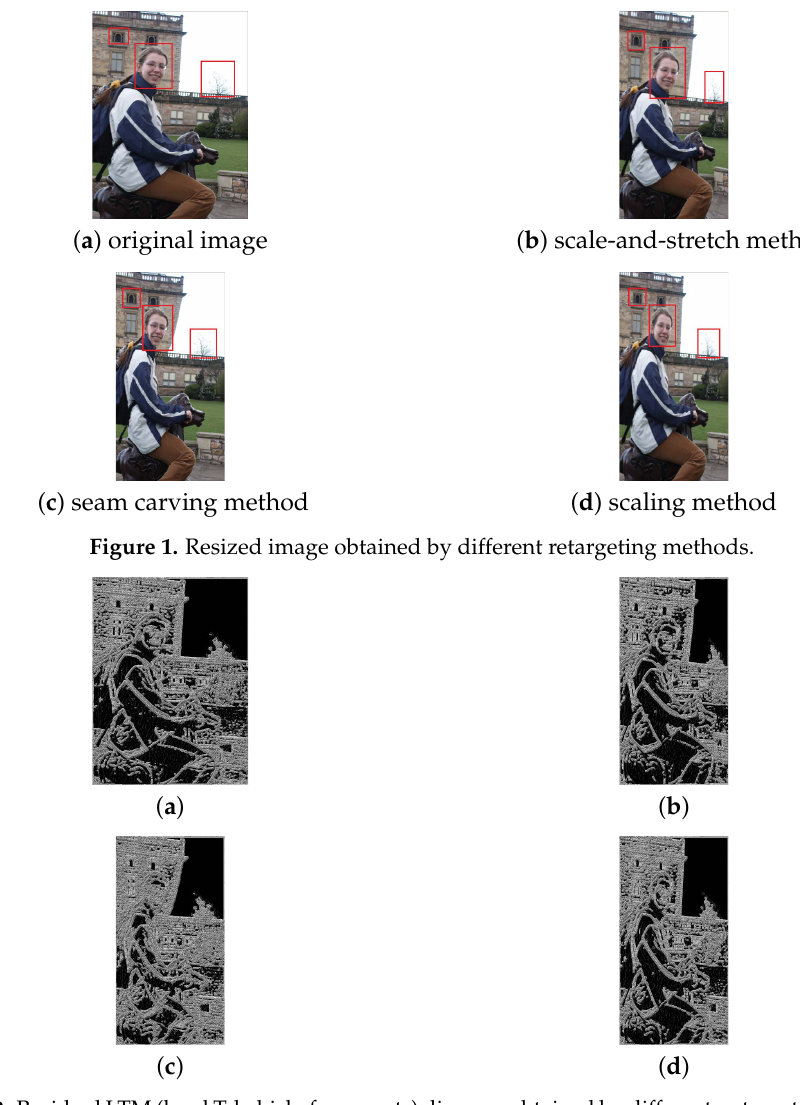
Figure 2. Residual LTM (local Tchebichef moments) diagram obtained by different re-targeting methods: ( a – d ) correspond to the residual LTM diagram of Figure 1a–d,